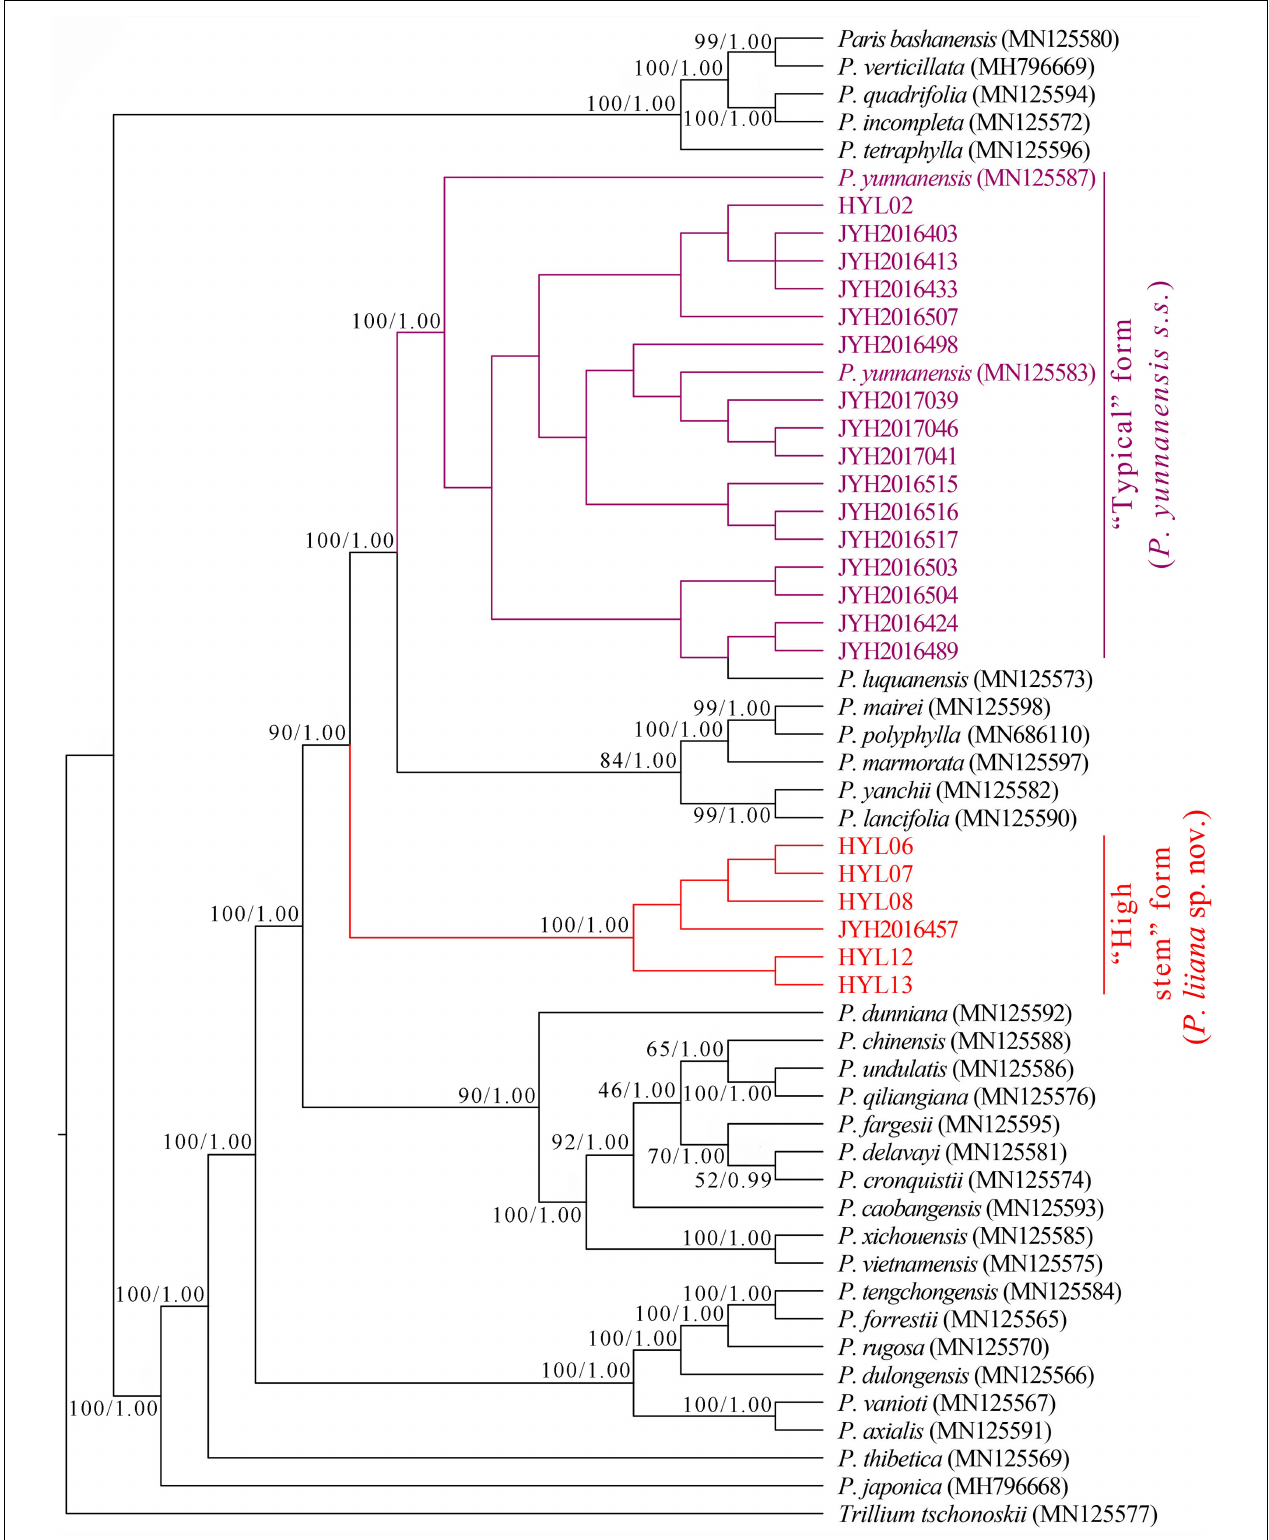
FIGURE 4 | Phylogenetic tree reconstructed via maximum-likelihood (ML) and Bayesian inference (BI) analyses of complete plastomes. Numbers above branches indicate likelihood bootstrap percentages (BP) and Bayesian posterior probabilities (PP).